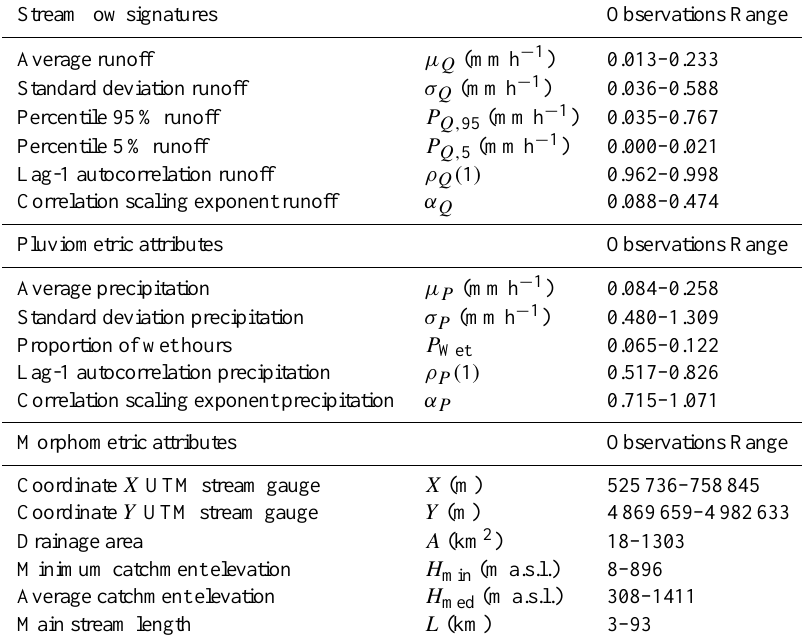
Table 1. Streamflow signatures, pluviometric and morphometric